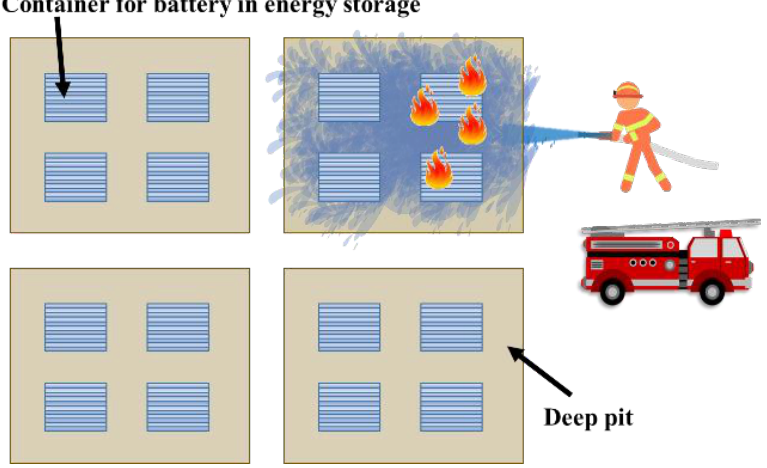
Figure 10. Immersive firefighting design for energy